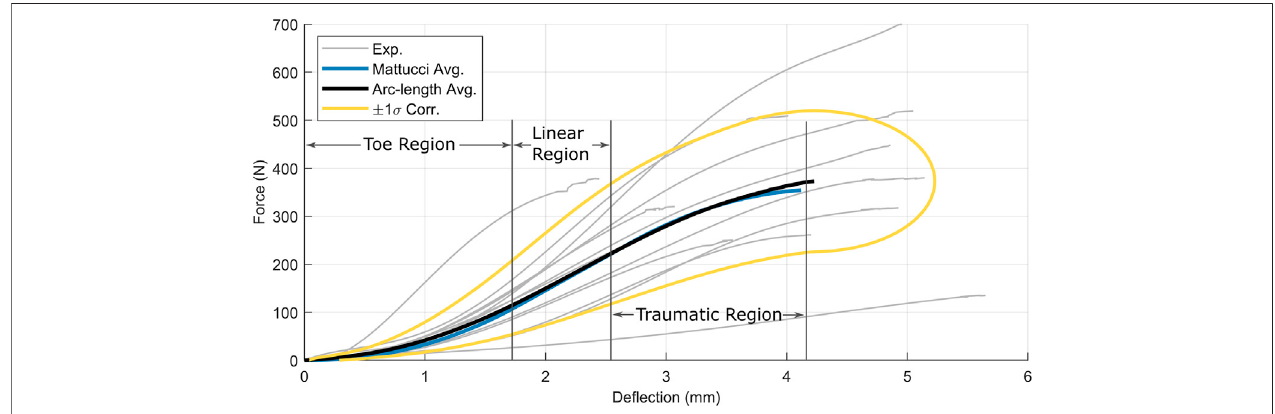
FIGURE 9 | Anterior longitudinal ligament force-displacement responses superimposed with Mattucci average (blue) and arc-length average (black) and ± 1 standard deviation corridors (gold). The three physiological regions of ligament behaviour are labelled: the toe region, the predominantly linear region, and the concave- down traumatic region.